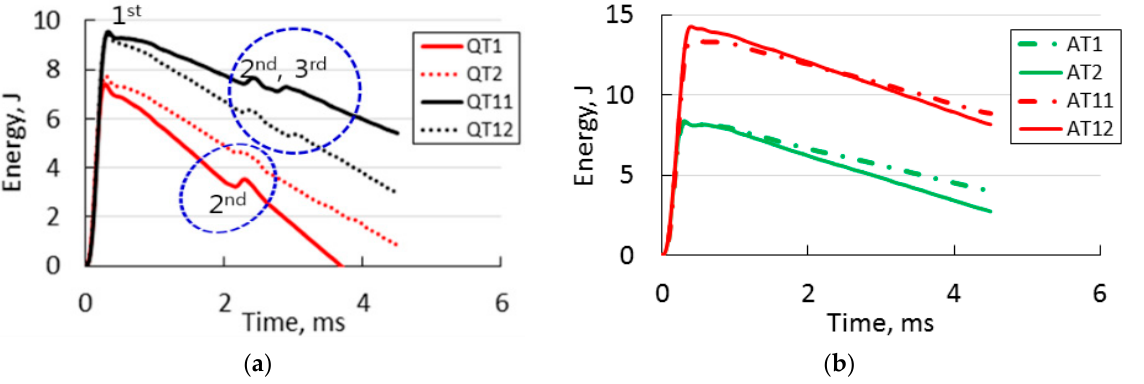
Figure 14. Comparison of Charpy impact toughness between ( a ) QT and ( b ) AT specimens with the standard V ‐ type notch and sharp I ‐ type notch.